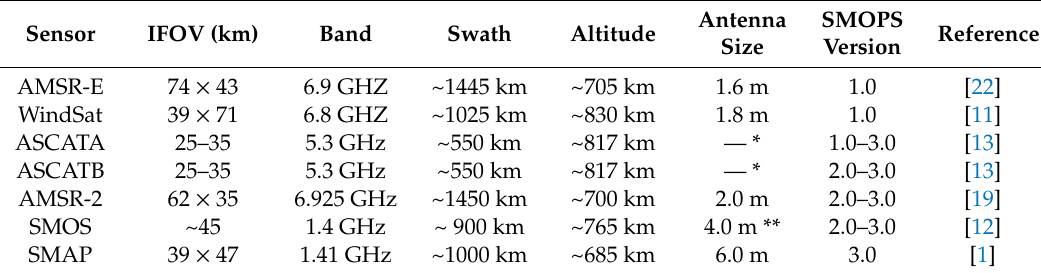
Table 1. Satellite sensors of which observations are combined into the daily soil moisture operational product system (SMOPS) blended soil moisture data